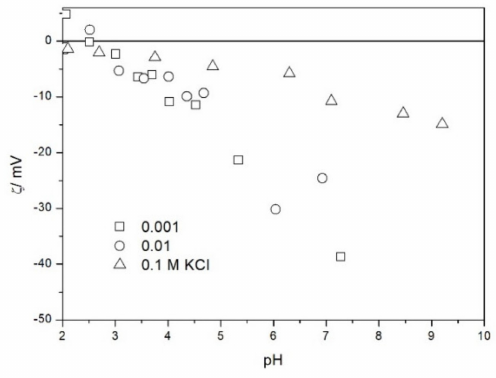
Figure 2. The zeta potential of TeO 2 in KCl.